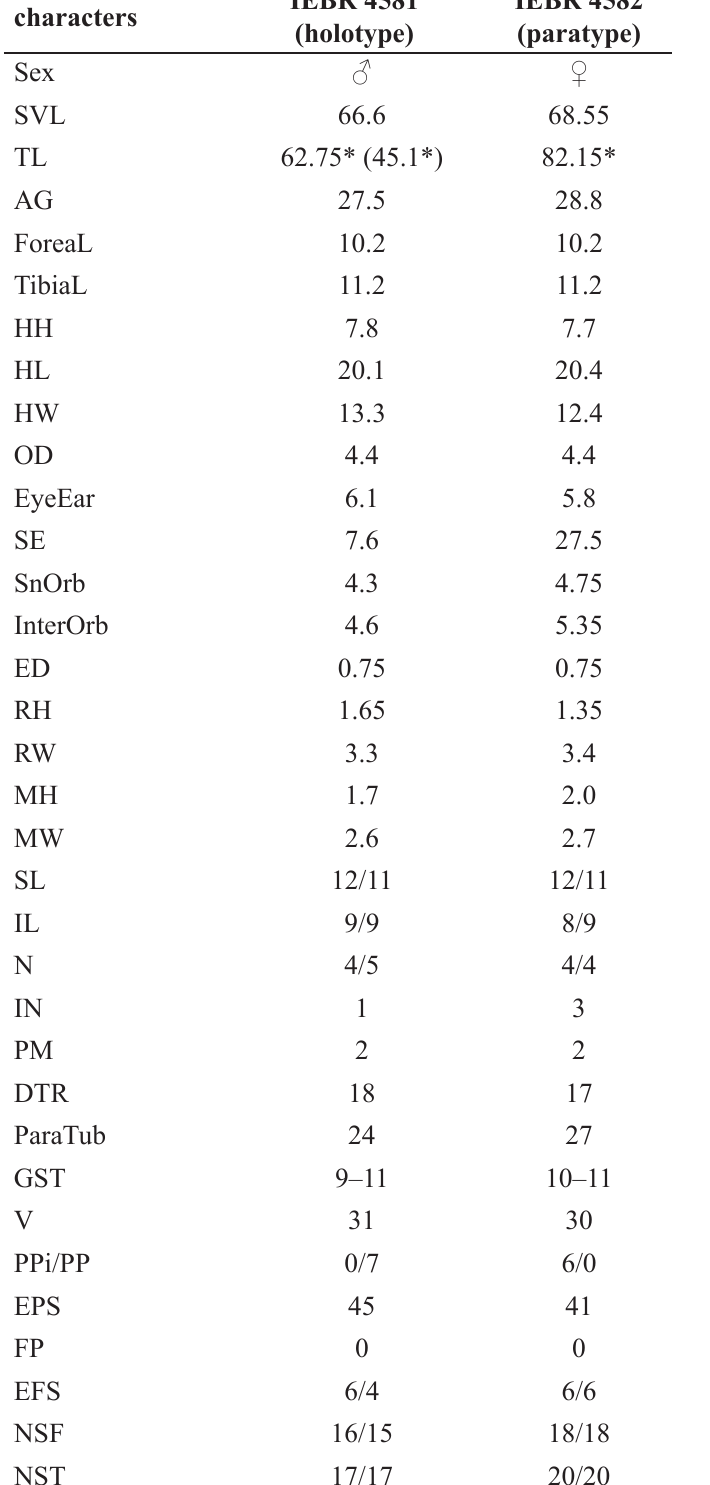
Table 1. Measurements (in mm) and morphological characters of type series of Cyrtodactylus chungi sp. nov. * = regenerated or broken tail; bilateral meristic characters are given as